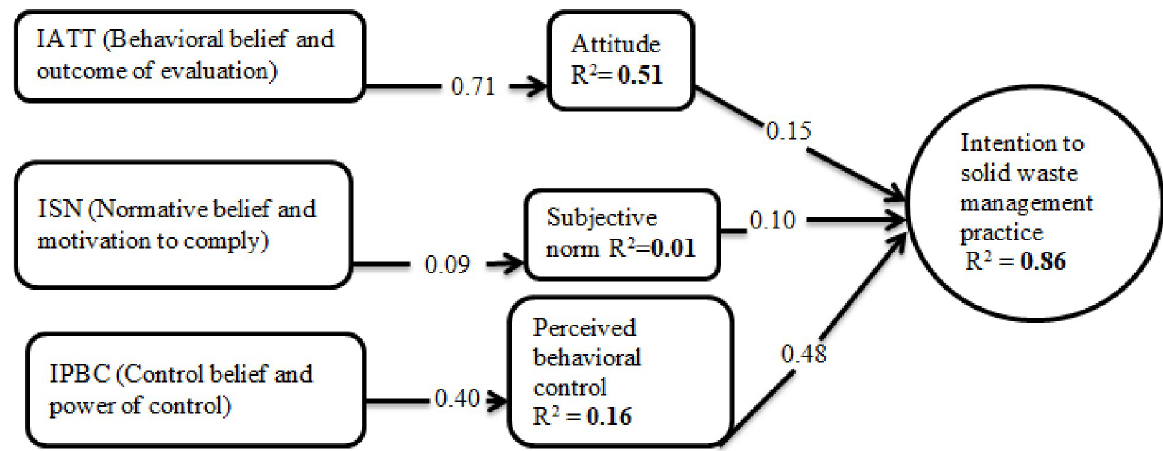
Fig 1. Standardized path coefficient of theory of planned behavior variables (significant at p < 0.05). IATT = indirect Attitude; ISN = indirect Subjective norm; IPBC = indirect perceived behavioral control.